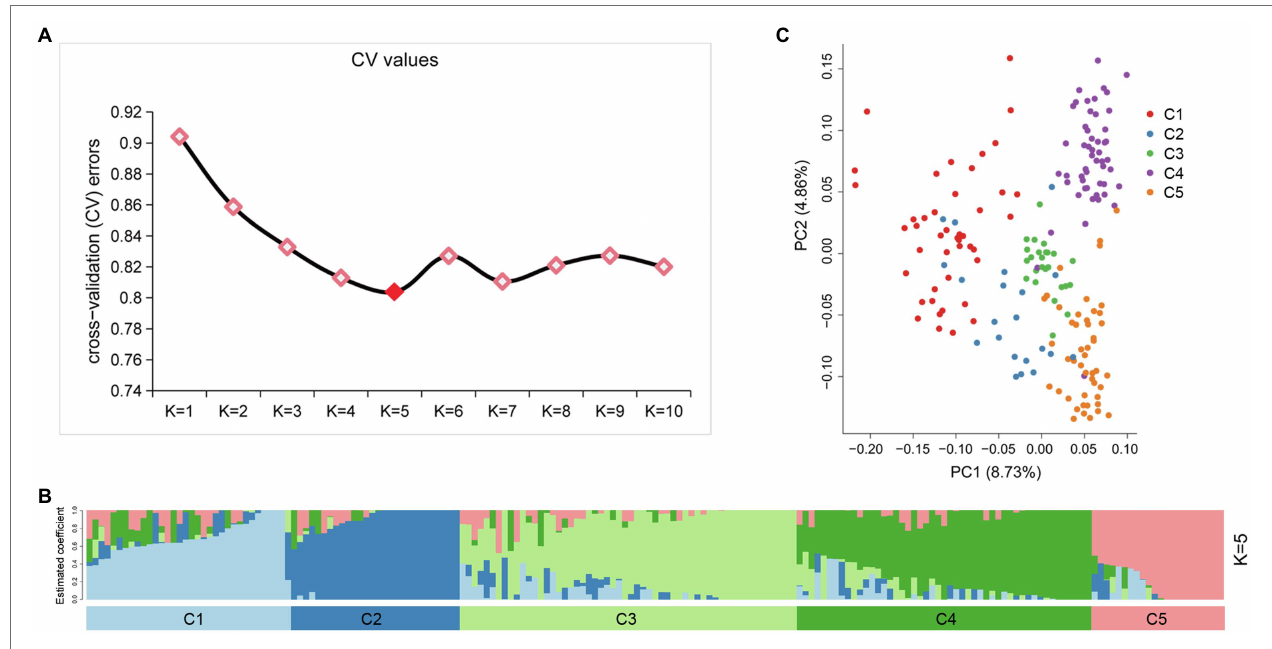
FIGURE 3 | Population structure of 189 potato genotypes based on SSR markers, the graphical presentation of estimation of (A) the cross-validation error plot exhibited as implemented in ADMIXTURE. (B) Population structure inferred using ADMIXTURE with K -value at five. (C) Principal component analysis using GCTA